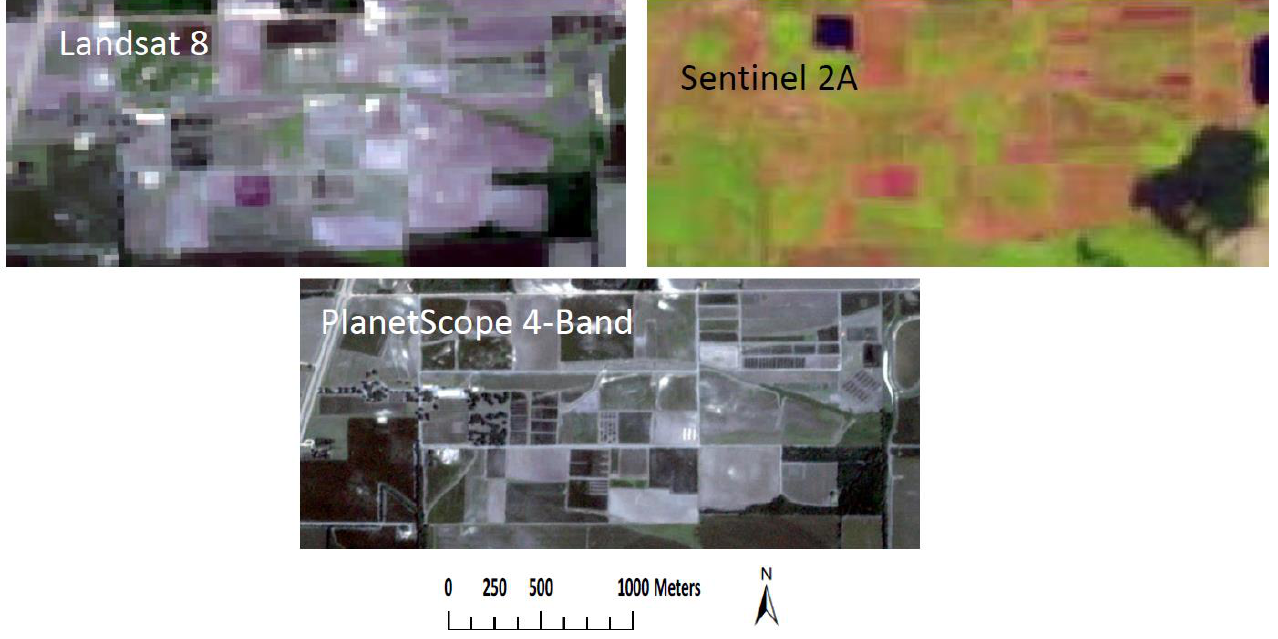
Figure 8. Satellite multispectral imagery of the research farm area at Brooksville, Mississippi: Landsat 8 (16 June 2018), Sentinel 2A (12 July 2018), and PlanetScope 4-band (4 July 2018).